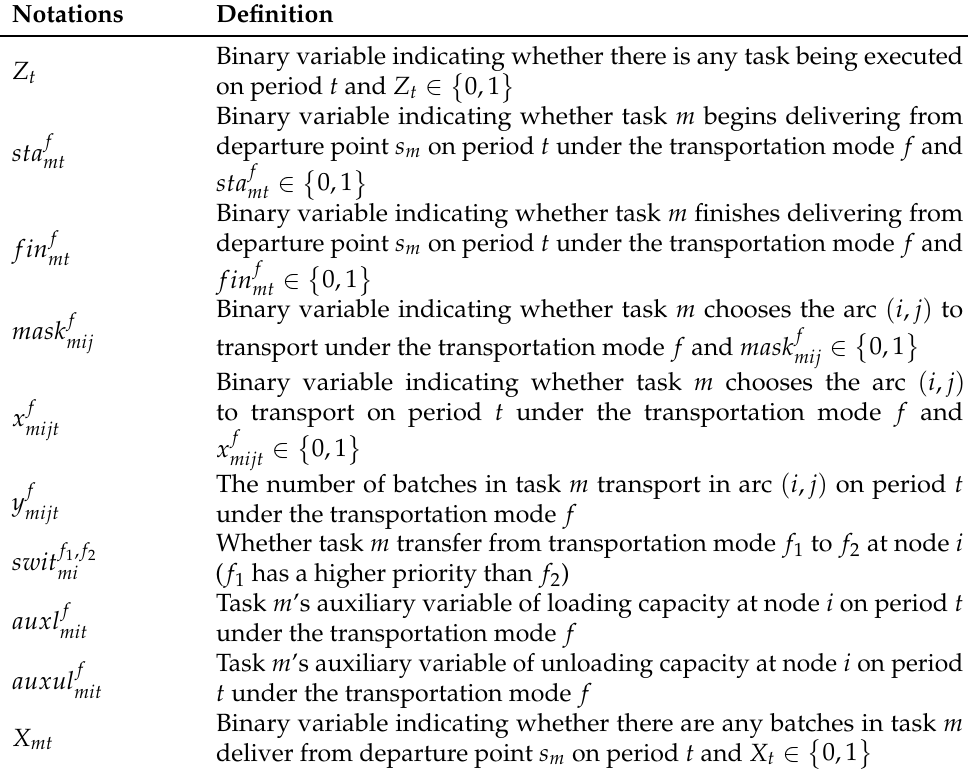
Table 2. Notations of decision variable used in the